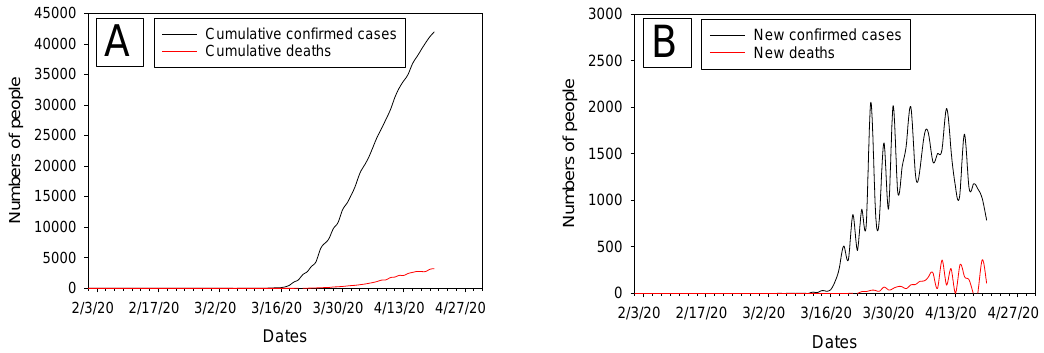
Figure 2. Daily variations of COVID-19 in Queens, New York between 1 February and 20 April 2020. ( A ) Cumulative confirmed cases and deaths; ( B ) New confirmed cases and deaths.